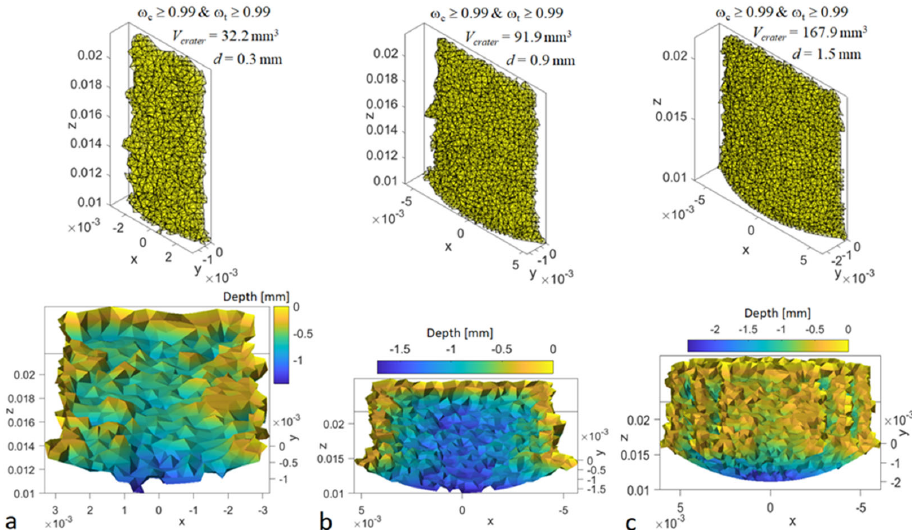
Figure 5. Simulation results for PDC cutting at different cutting depths: removed elements and shape of cut grooves at ( a ) d = 0.3 mm, ( b ) d = 0.9 mm, and ( c ) d = 1.5 mm.